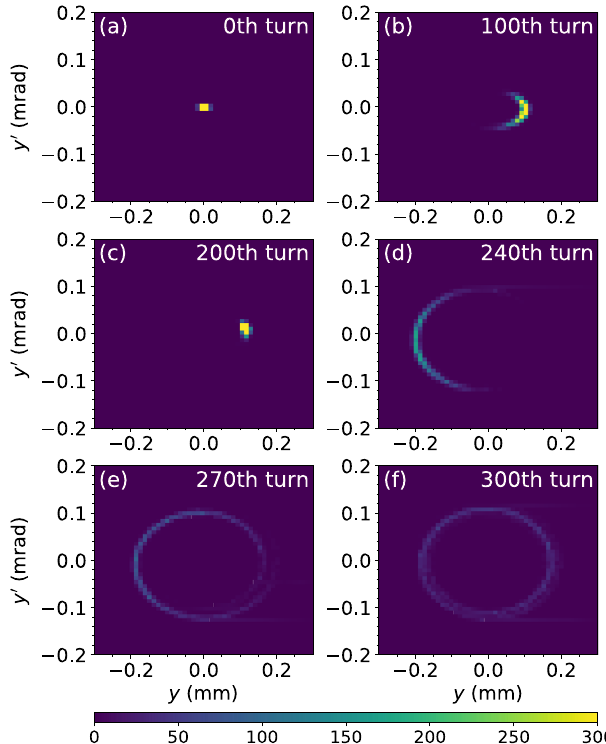
FIG. 4. ð y; y 0 Þ phase space distribution of 5000 particles in a single bunch (a) at the 0th, (b) 100th, (c) 200th, (d) 240th, (e) 270th, and (f) 300th turn, respectively, simulated by CETRA . In the simulation, the magnitude and the frequency of a sinusoidal kick are, respectively, set to 2 μ rad and ν f ¼ 9 . 230 . In addition, the x - y coupling of 1% is introduced, assuming the actual ring